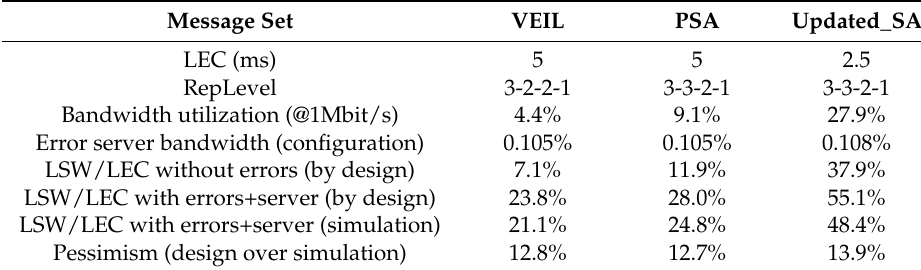
Table 5. Minimum LSW configuration value by design and